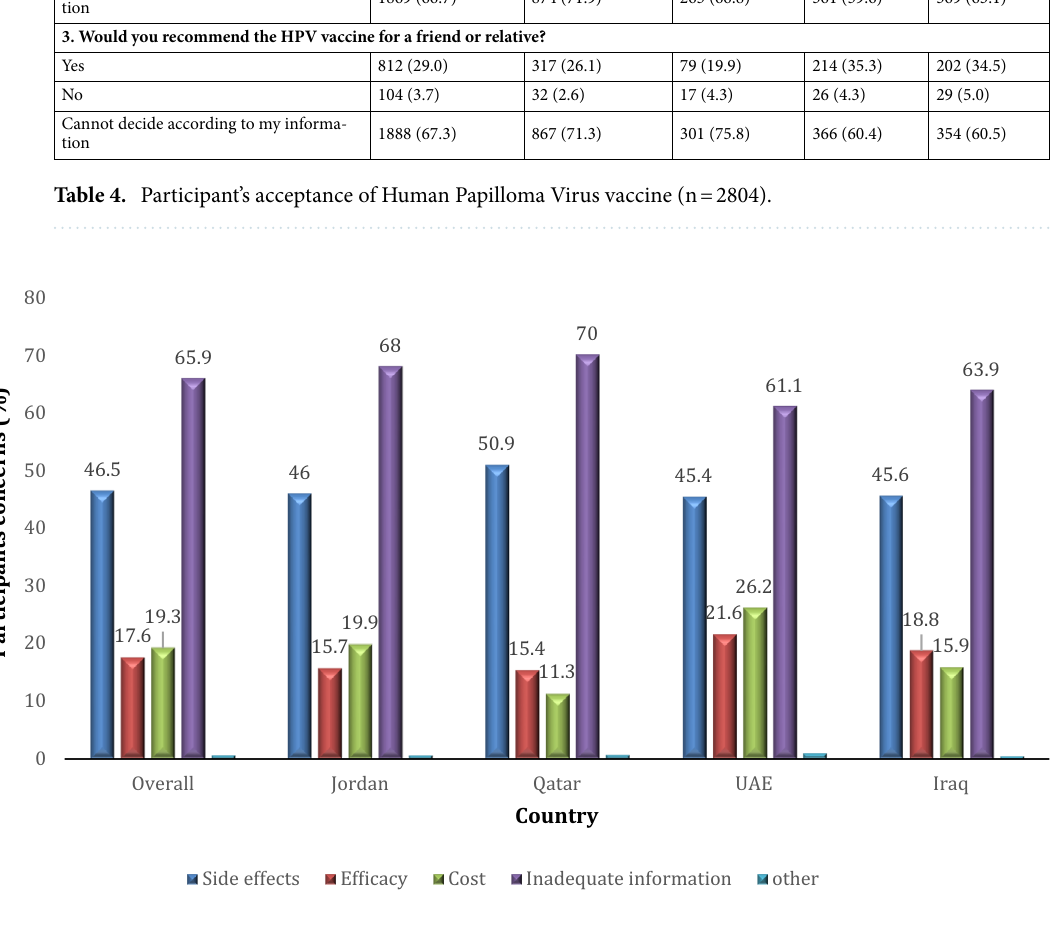
Figure 1. Participants concerns about receiving or recommending HPV vaccine (n =